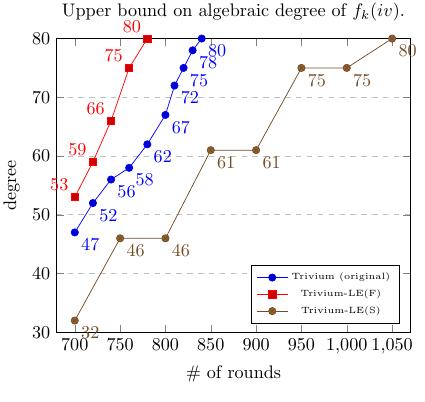
Figure 17: Increase in algebraic degree with respect to the number of initialization